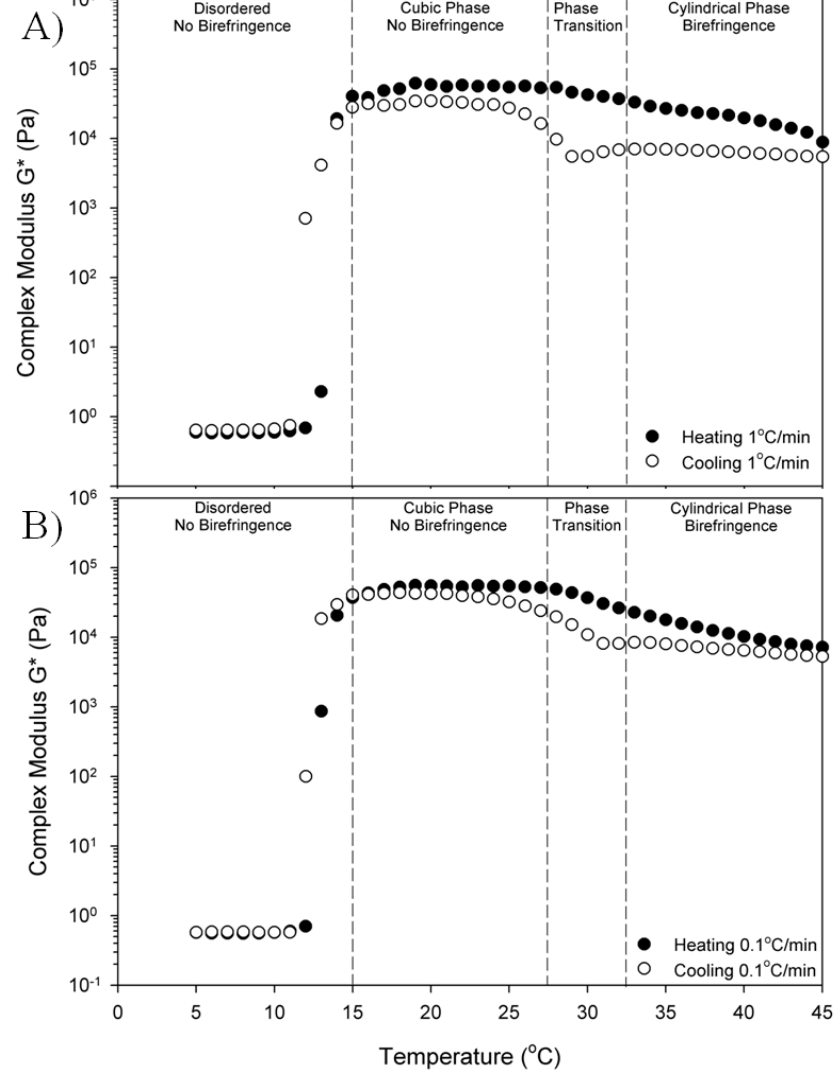
= 10 Pa for disordered phase, σ = 100 Pa for o o